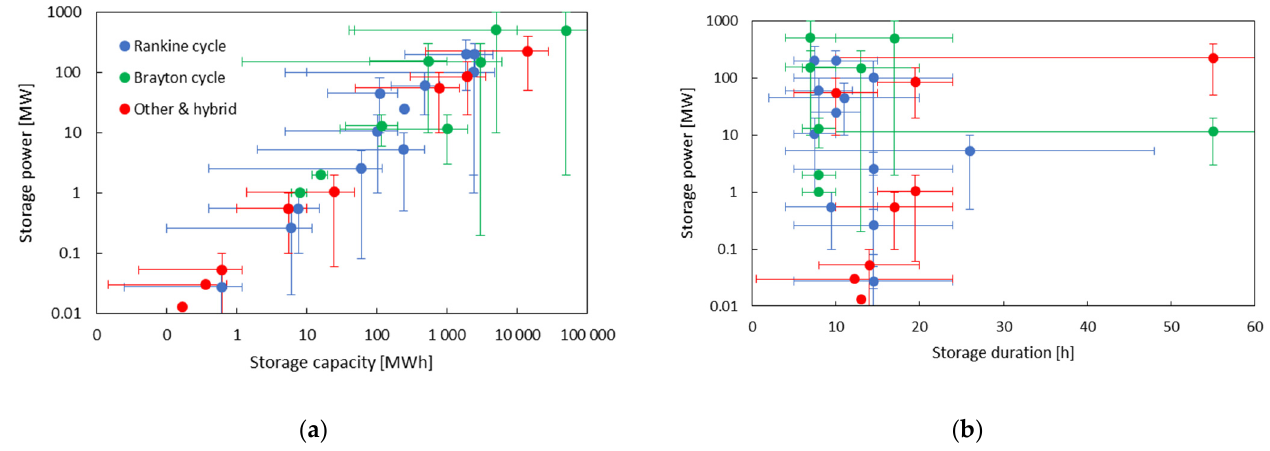
Figure 5. Storage power output and capacity ( a ) and discharge duration ( b ) for the commercially developed CB systems.